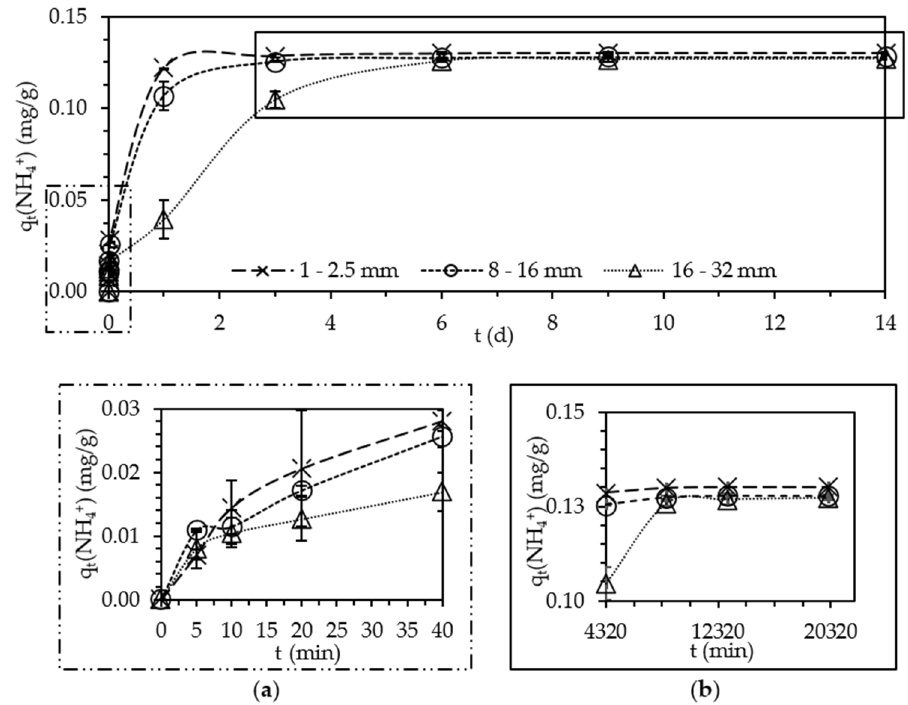
Figure 1. Time-dependent ammonium sorption capacity q t of CLP85+ with different grain sizes as a function of the exposure time (matrix: ultrapure water; t eq : 14 d; pH 0 : 5.9; c 0 (NH 4+ ) = 10 mgN/L; w / v = 100 g Z /L; T = 22 °C; grain size: 1–2.5 mm, 8–16 mm, 16–32 mm; n = 3).